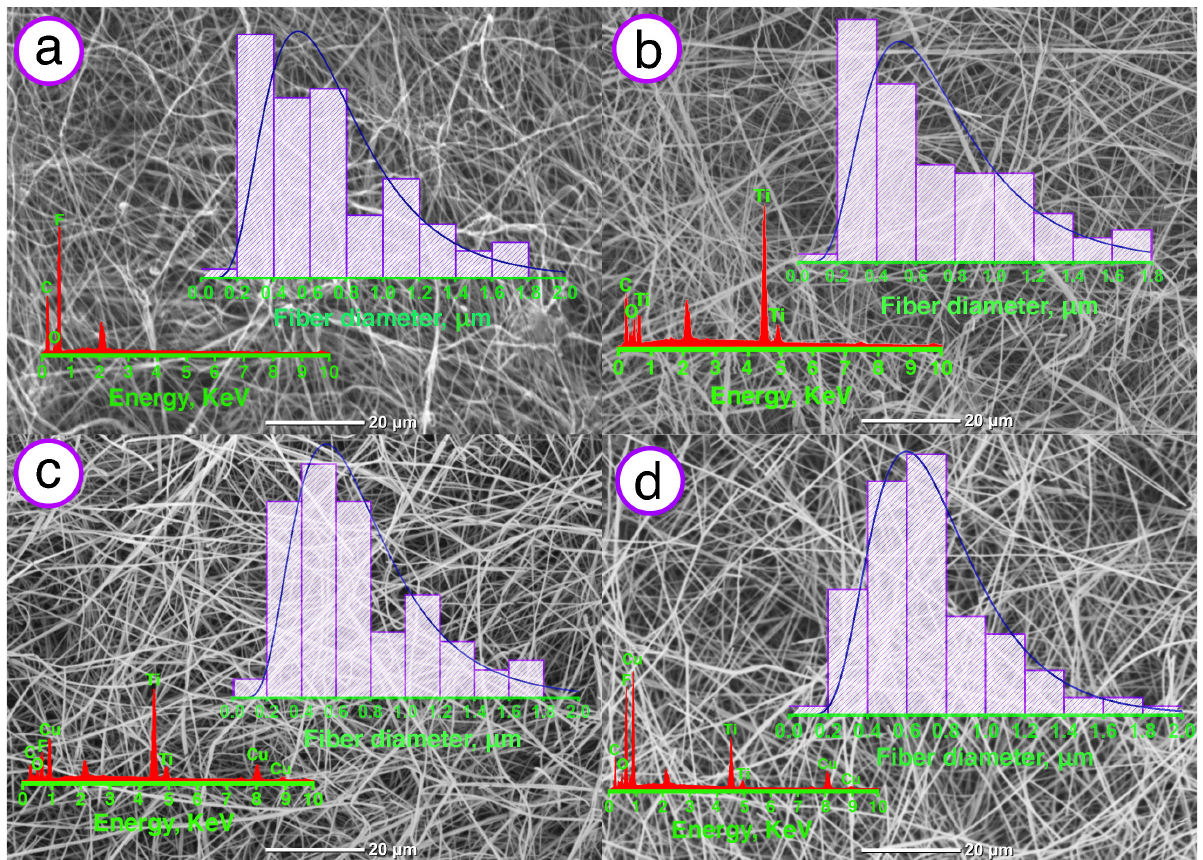
Figure 2. SEM images, fiber diameter histograms and energy dispersive X-ray spectroscopy (EDAX) spectra of: ( a ) Pristine (unmodified VDF-TeFE scaffold); ( b ) Ti; ( c ) Ti/Cu 1; ( d ) Ti/Cu 2.